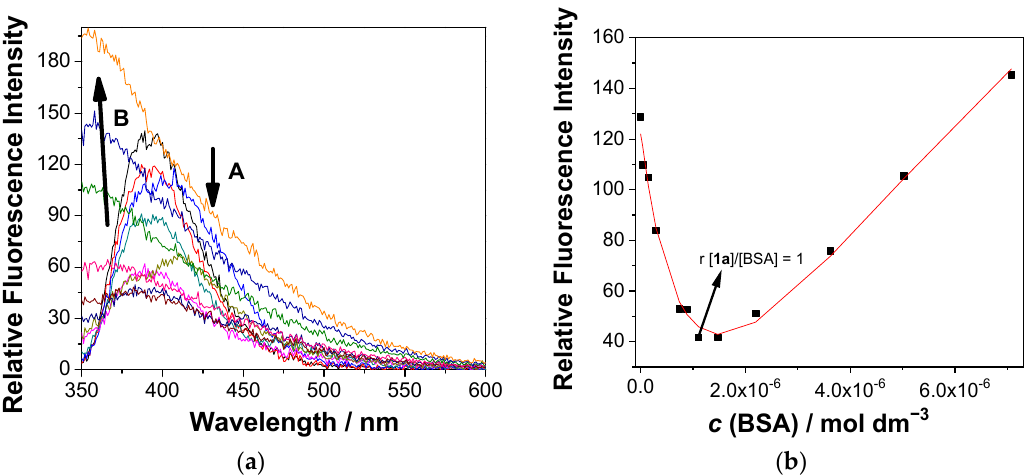
Figure 4. ( a ) Fluorescence spectra ( λ exc = 320 nm) of 1a ( c = 1.0 × 10 − 6 M) in the presence of different concentrations of BSA. ( b ) Dependence of the fluorescence intensity at 390 nm on the BSA concentration. The black dots are experimental values and the red line is the fit to the model, involving 1a@BSA in the stoichiometric ratios of 1:1 and 2:1. The measurement was conducted in aqueous solution, containing 0.05 M sodium cacodylate buffer at pH = 7.0, at 25 °C (containing <1% DMSO).